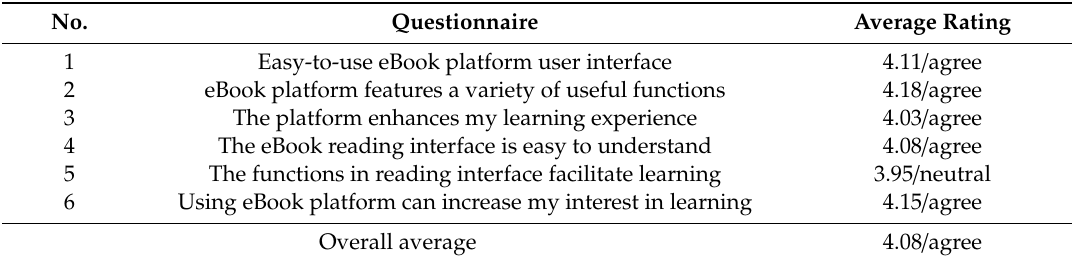
Table 4. Students’ responses regarding the eBook platform user interface. ( n =